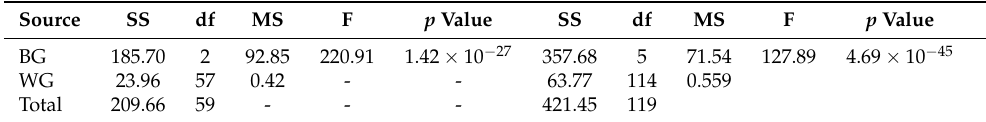
Table 6. Using the RRSYNTH dataset, the ANOVA results were obtained from the CASVR, CALSTM, and the proposed CAGBA models; the right side columns were obtained from SVRMF, CASVR, LSTMMF, CALSTM, GBAMF, and CAGBA models.